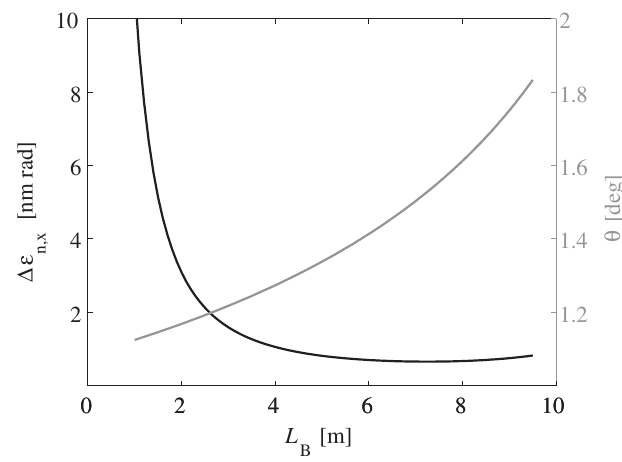
FIG. 2. Variation of ISR emittance growth (black, left axis) and bending angle (gray, right axis) with dipole